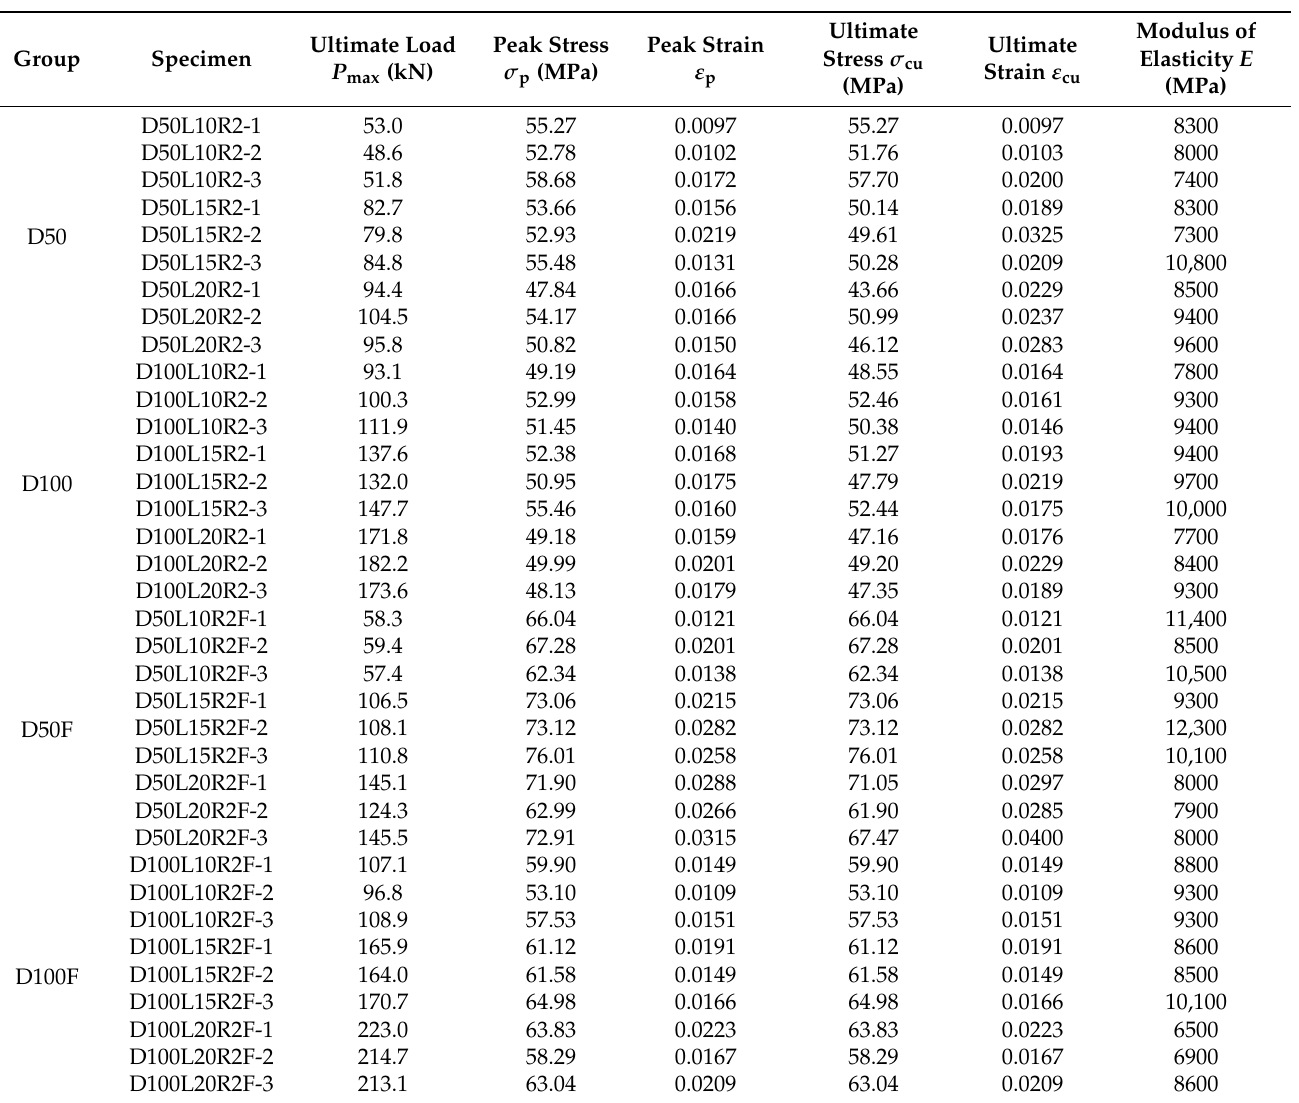
Figure 7. Comparison of the axial stress considering different compression areas. ( a ) D100L20R2F-1; ( b ) D100L15R2F-1. Table 4. The results of the bamboo composite tubes under axial